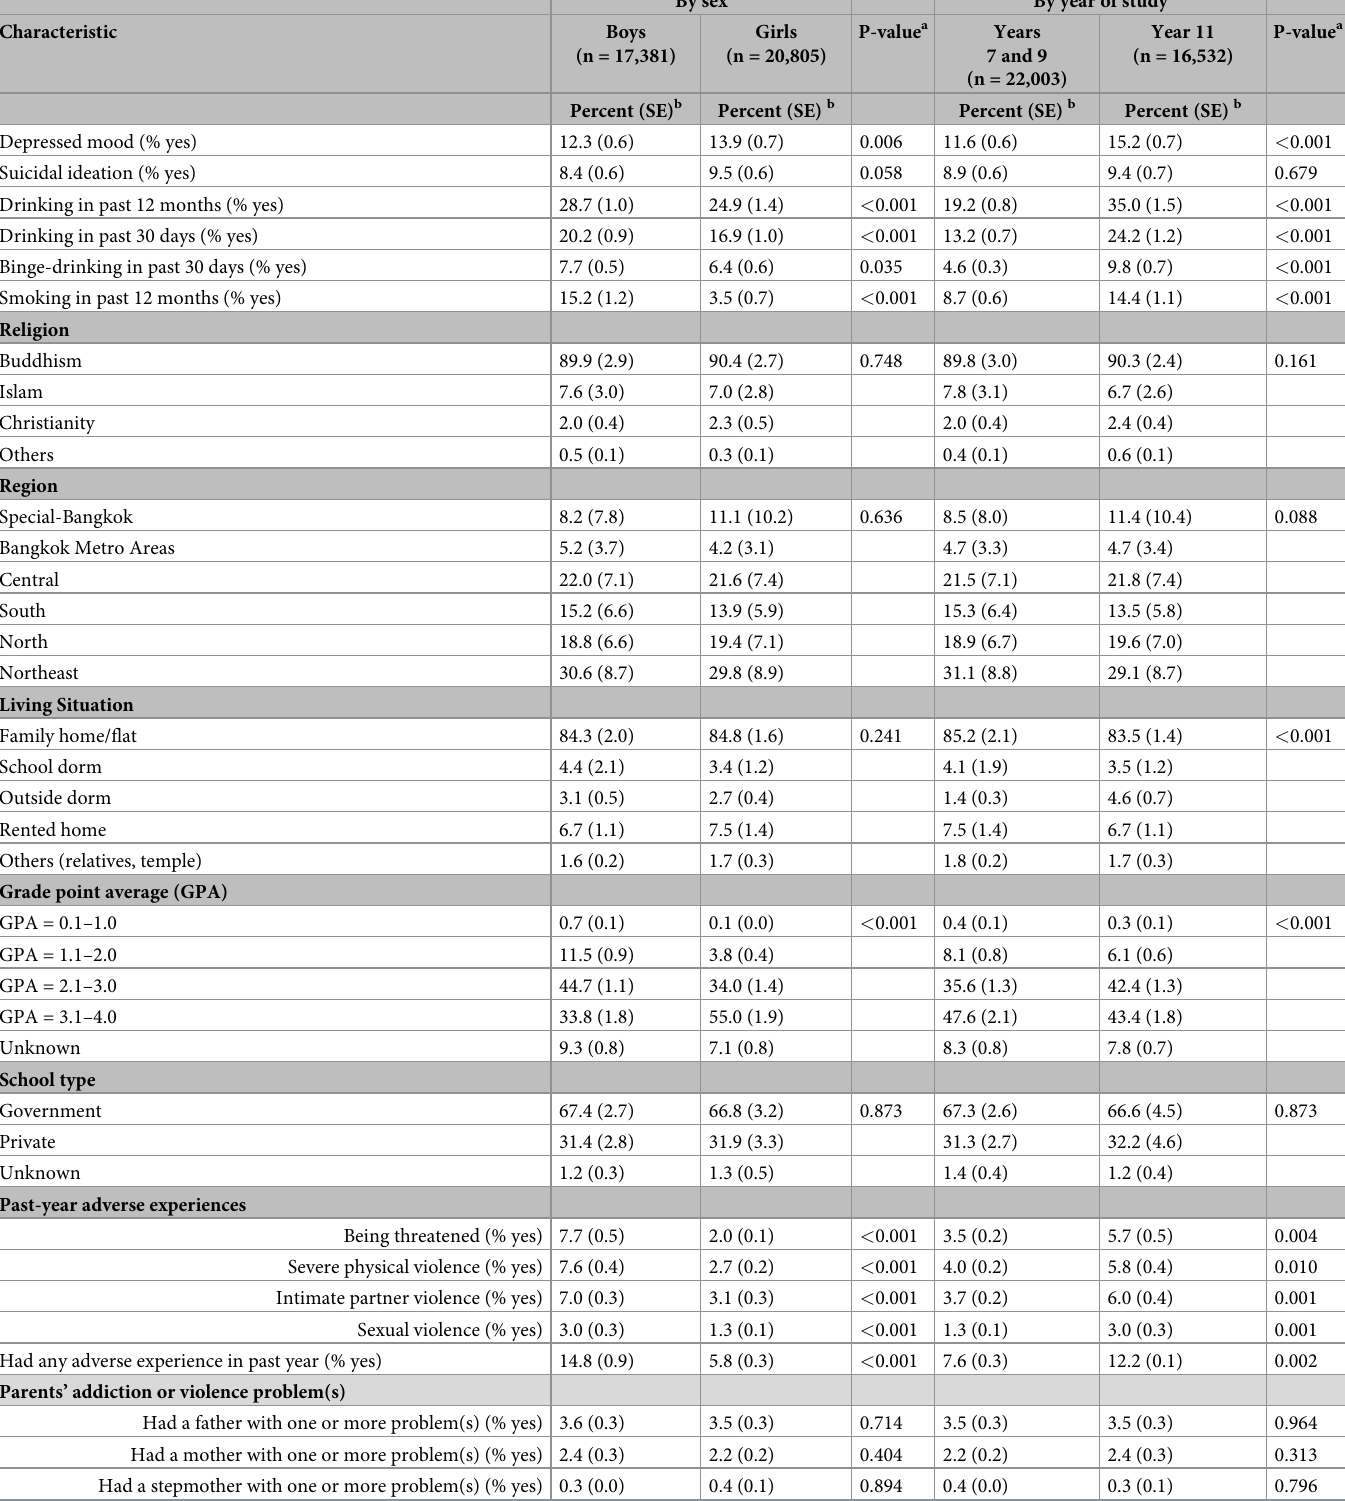
Table 1. Prevalence of demographic factors, drinking, smoking, suicidal behaviors, and depressed mood among study participants.